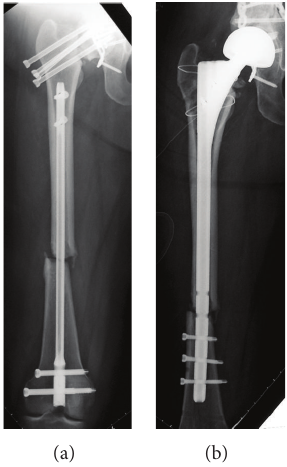
Figure 5: Radiographs of the right femur after the first two operations and after arthroplasty. (a) At 15 weeks after the first two operations, the screws at the femoral neck are loose with nonunion of the femoral neck and shaft. (b) A radiograph showing that arthroplasty was successfully performed.